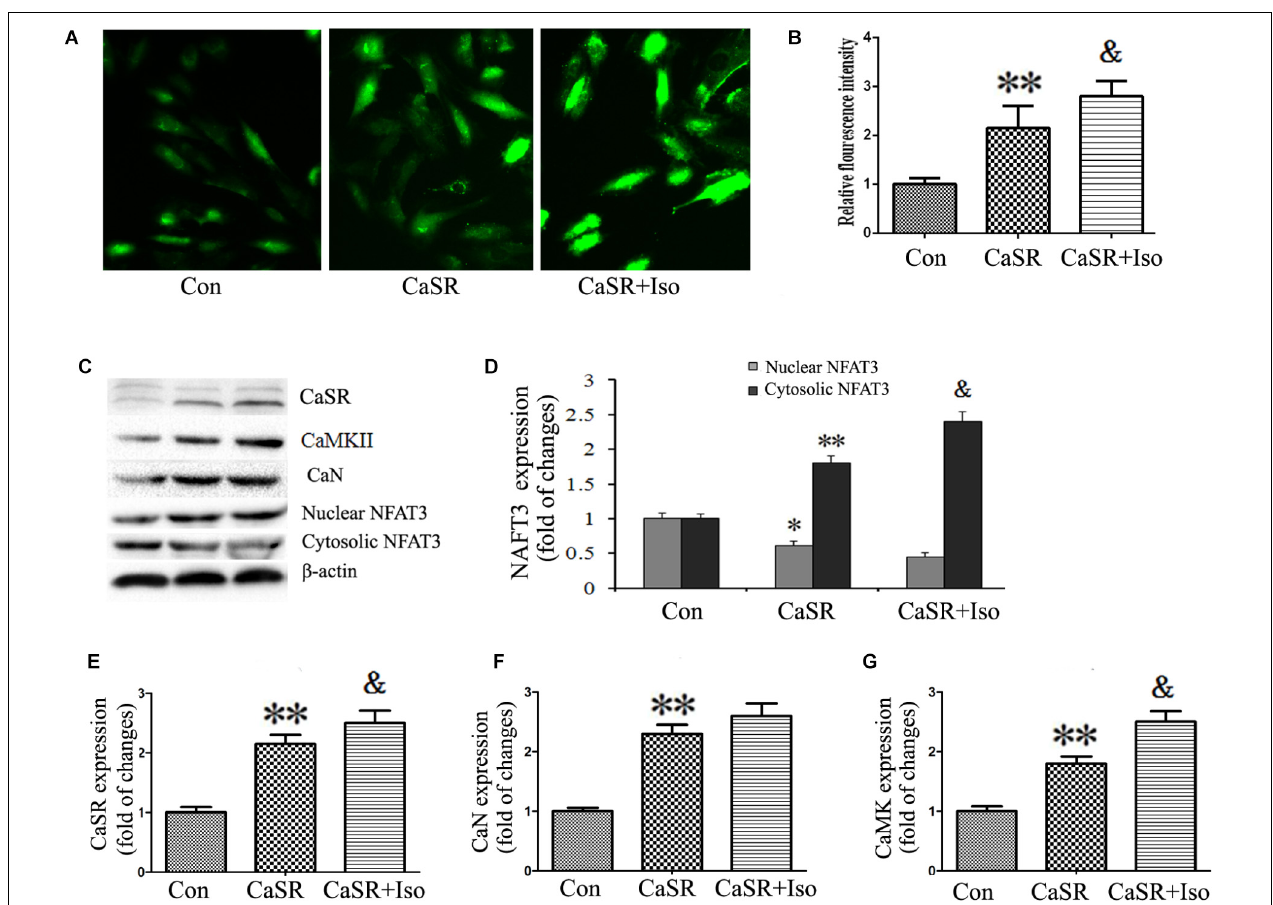
FIGURE 9 | Regulatory effect of CaSR activation on [Ca 2 + ] i and the CaMKII and CaN pathways. (A) Changes in the intensity of fluorescence of [Ca 2 + ] i were recorded with a laser scanning confocal microscope under different treatment conditions. (B) The bars represent the fluorescence relative to that of the controls. (C–G) CaSR, CaMKII, CaN and NFAT-3 protein expression assayed by western blot in H9C2 cells. The data are expressed as the means ± SEM, n = 4. ∗∗ P < 0.01 vs. the Con group; & P < 0.05 vs. the CaSR